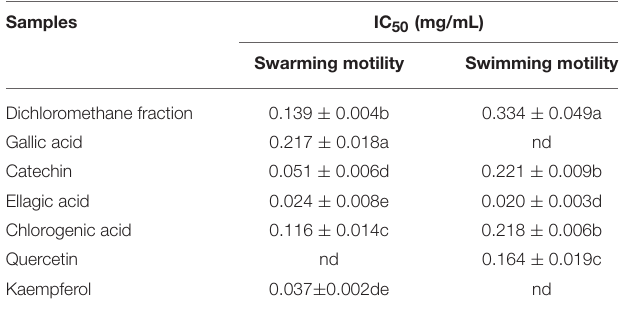
TABLE 4 | Half maximal inhibitory concentrations (IC 50 ) of the dichloromethane fraction and six compounds identified from Camellia nitidissima Chi flowers on the swarming motility and swimming motility of Pseudomonas aeruginosa